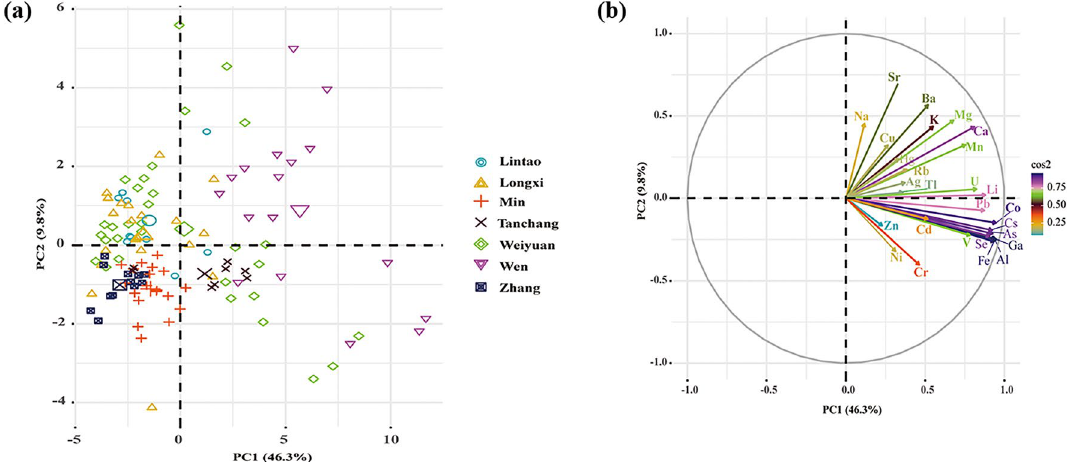
Figure 1. Score ( a ) and loading ( b ) plots of the first principal component (PC1) versus the second principal component